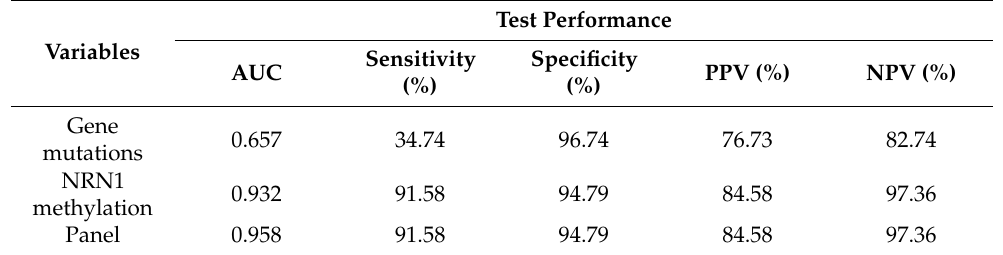
Figure 3. ( A ) The NRN1 methylation ∆ Ct-value distribution of the included patients. Red and blue triangles represent the NRN1 methylation level of individuals in UTUC and non-UTUC group, respectively. ( B ) ROC curve of NRN1 methylation (AUC = 0.932), gene mutation (AUC = 0.651) and the panel (AUC = 0.958), respectively. Table 2. The detection performance of three diagnostic tools in identifying UTUC.